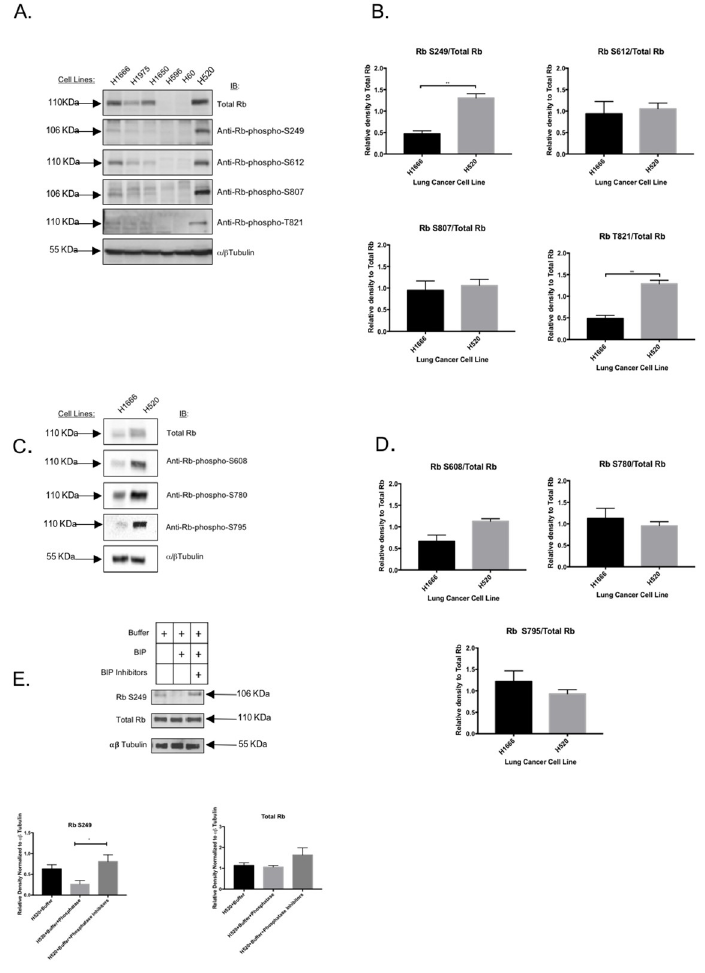
cancer cell lines. These residues were shown by LC-MS/MS to be hyper-phosphorylated in H520 cells relative to H1666 cells. The bottom lane shows a blot for alpha-beta tubulin as a loading control. (B) These immunoblots were conducted in triplicates and quantified by densitometric analyses of band intensity using the ImageJ Plug-in. Each data point normalizes the Rb phosphorylation signal against total Rb expression. Error bars are standard error of the mean. Only the Rb phosphorylation on S249 and T821 were increased in H520 cells relative to H1666 cells in a statistically significant manner. (C) and (D) Immunoblot analyses (C) and quantification of band intensity (D) of Rb phosphorylated residues which were not detected by mass spectroscopy to be differentially phosphorylated between H1666 and H520 cell lines. Each data point represents the band intensity of the phosphorylated Rb residue normalized against total Rb expression. None of these residues were differentially phosphorylated between H1666 and H520 cells in a statistically significant manner. (E) Whole protein extracts from H520 cells were treated with bovine intestinal alkaline phosphatase (BIP) buffer alone (first immunoblot lane), with BIP in phosphatase buffer (middle immunoblot lane) and with BIP in its buffer plus BIP inhibitors (third immunoblot lane). BIP treatment diminished the intensity of the Rb S249 band in a statistically significant manner without affecting total Rb levels. This effect was reverted in the presence of BIP inhibitors. In all quantification data, error bars are standard error of the mean, and statistical tests